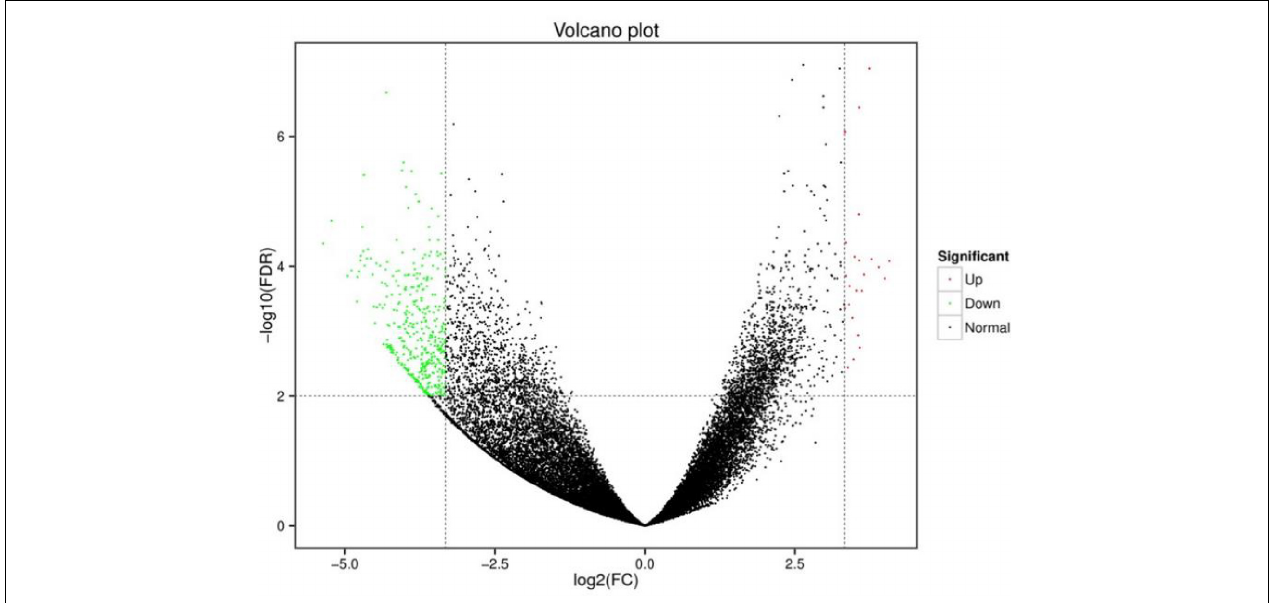
FIGURE 4 | Volcano map of differentially expressed genes in spleen of hybrid grouper fed fresh fish oil (R group) and highly oxidized fish oil (H group).